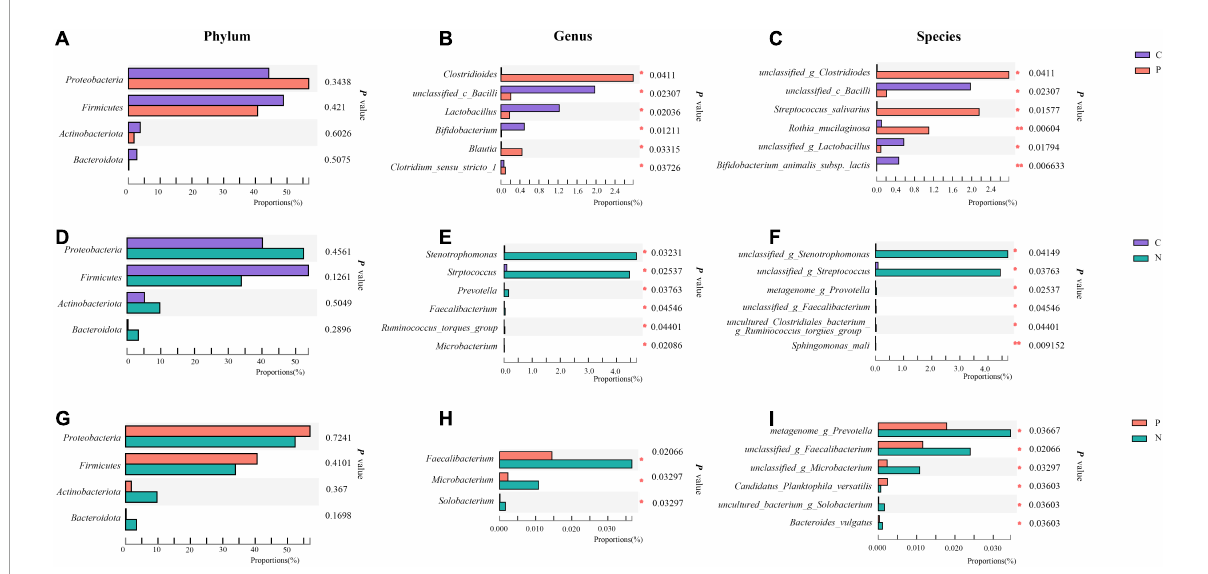
FIGURE3 Community abundance of the gut microbiota in Groups C, P, and N. Differences between Groups C and P at the phylum (A) , genus (B) and species (C) levels. Differences between Groups C and N at the phylum (D) , genus (E) and species (F) levels. Differences between Groups P and N at the phylum (G) , genus (H) and species (I) levels. ∗ P < 0.05, ∗∗ P <